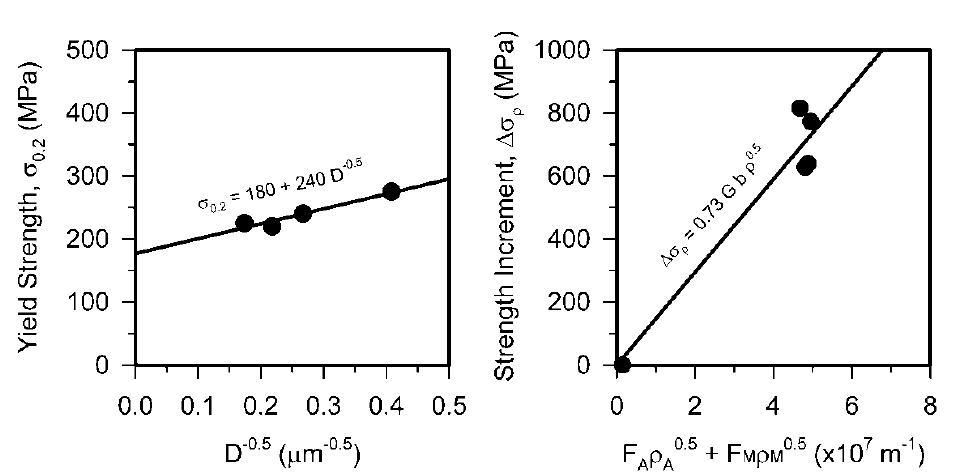
Figure 7. Hall-Petch relationship for a 304L stainless steel with annealed recrystallized microstructure and the effect of dislocation density (ρ) on the strength increment (∆σ ρ